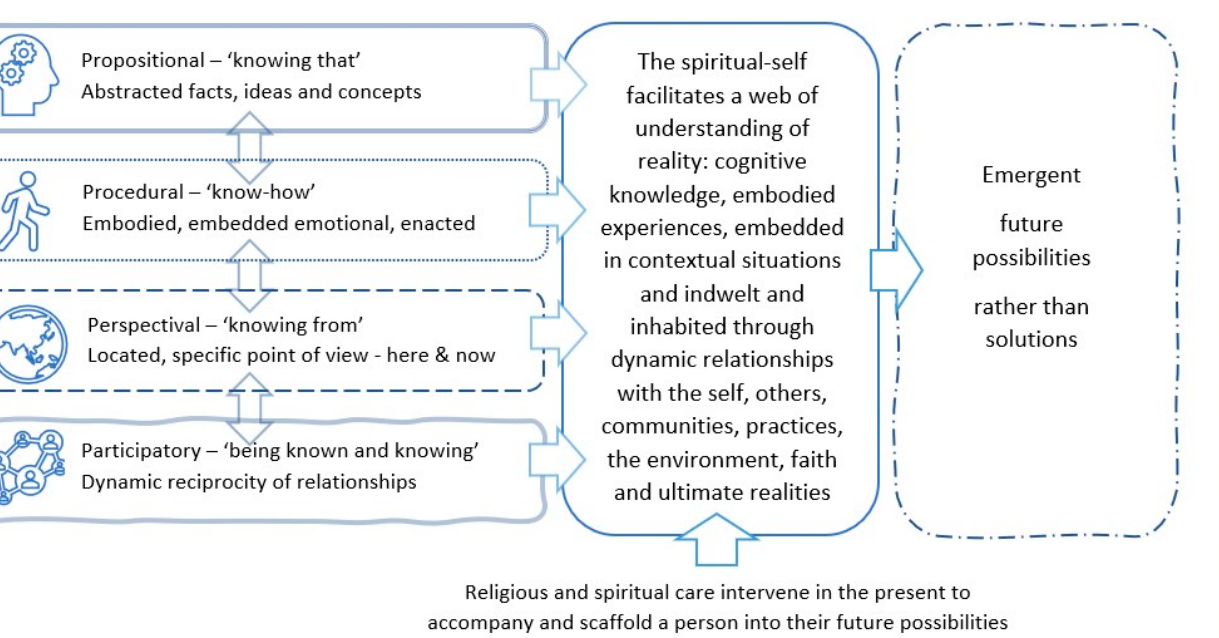
Figure 1. The four ways of knowing, drawing on work by Vervaeke and Ferraro (2013).